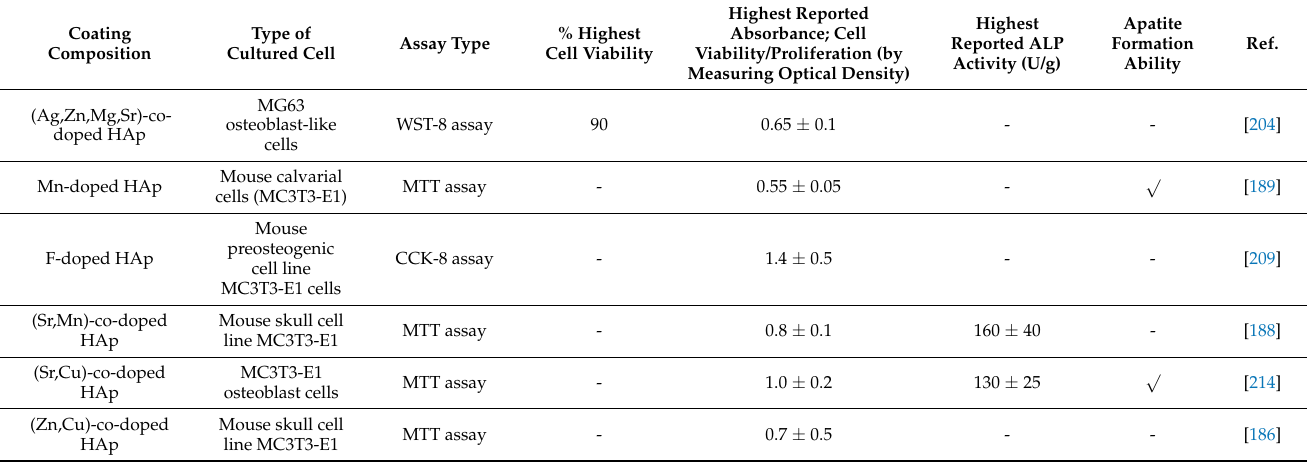
Table 11. The biological characteristics of the electrodeposited mineral(s)-substituted HAp coatings. Coating